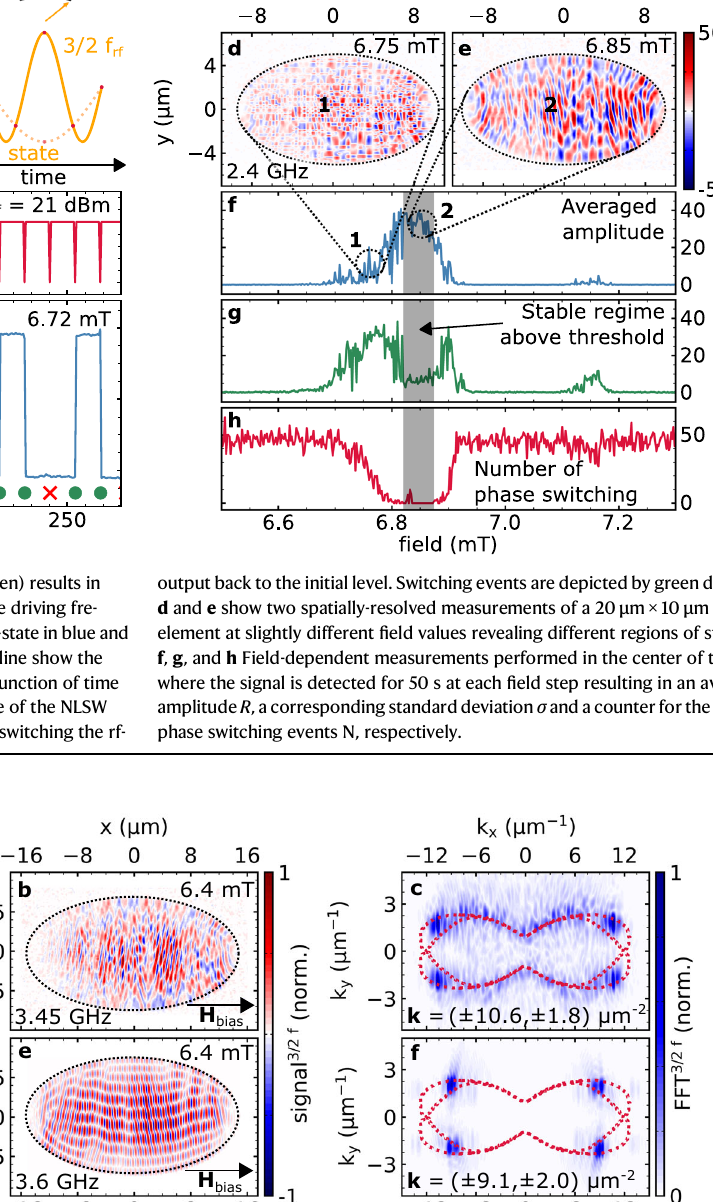
in c . Here, the dotted red lines, depict the iso-frequency line from non-linear spin- wave dispersion obtained with the analytical model. In d and e , micromagnetic simulations for the same element geometry are presented using similar conditions. The resulting 2D-FFT is depicted in f indicating the same spin-wave pattern with slightly smaller wave vector components.